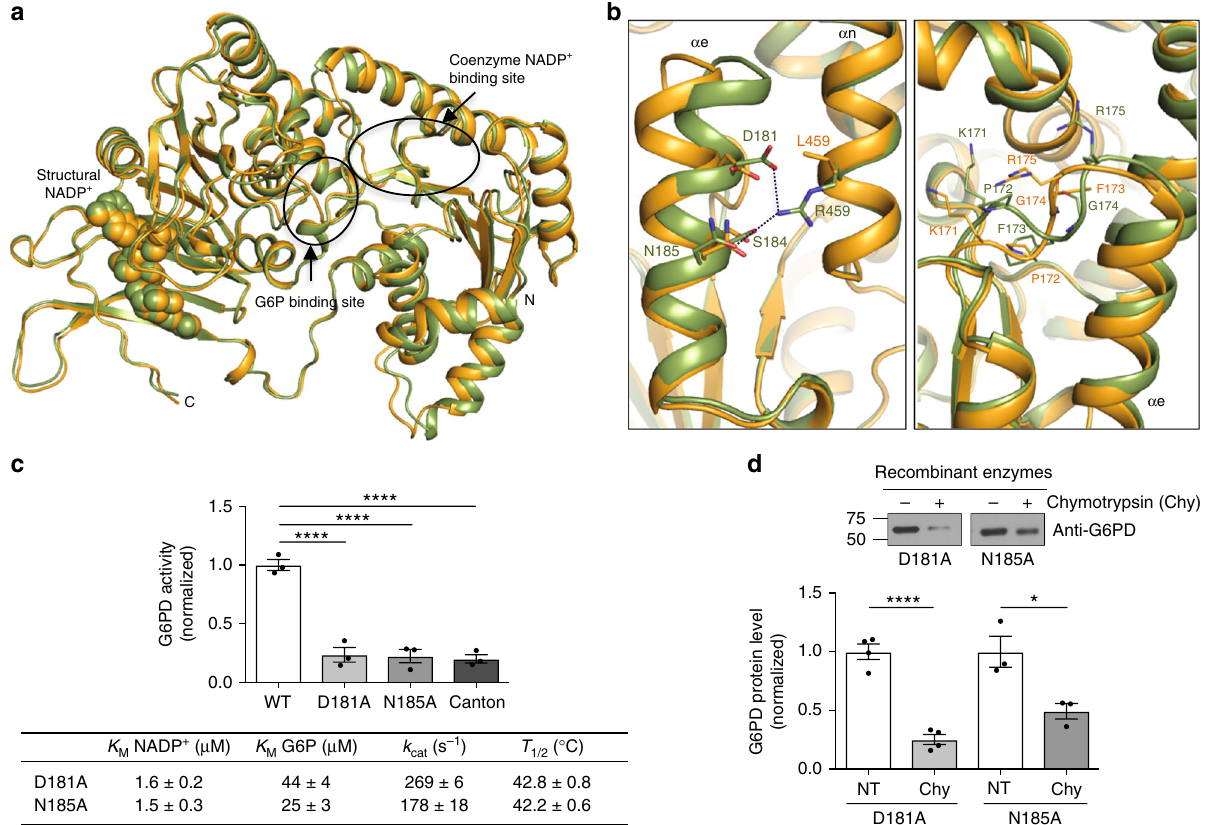
Fig. 2 Canton mutation (R459L) loses essential inter – helical interactions. a Structural overlay of WT G6PD (green) and Canton variant (orange). Structural NADP + is shown as spheres, and arrows and circles indicate G6P and catalytic NADP + -binding sites (G6P and catalytic NADP + were not observed in our structures). b (Left) Inter-helical interactions through R459 on the α n helix in WT G6PD and side chains of D181 and N185 on the adjacent helix ( α e). (Right) Canton mutation loses such interactions, leading to displacements of the helix ( α e) and a loop containing K171, P172, F173, G174 and R175 that precedes the helix. c , d Mutations of R459-interacting residues on the α e helix showed Canton mutation-like activity and thermostability ( n = 3, **** p < 0.0001, one-way ANOVA) and were also susceptible to chymotrypsin treatment ( n = 4 for D181A, **** p < 0.0001; n = 3 for N185A, * p = 0.026, two-tailed unpaired Student ’ s t -test). Error bars represent mean ± SEM. NT no treatment; WT: wild-type; Chy: